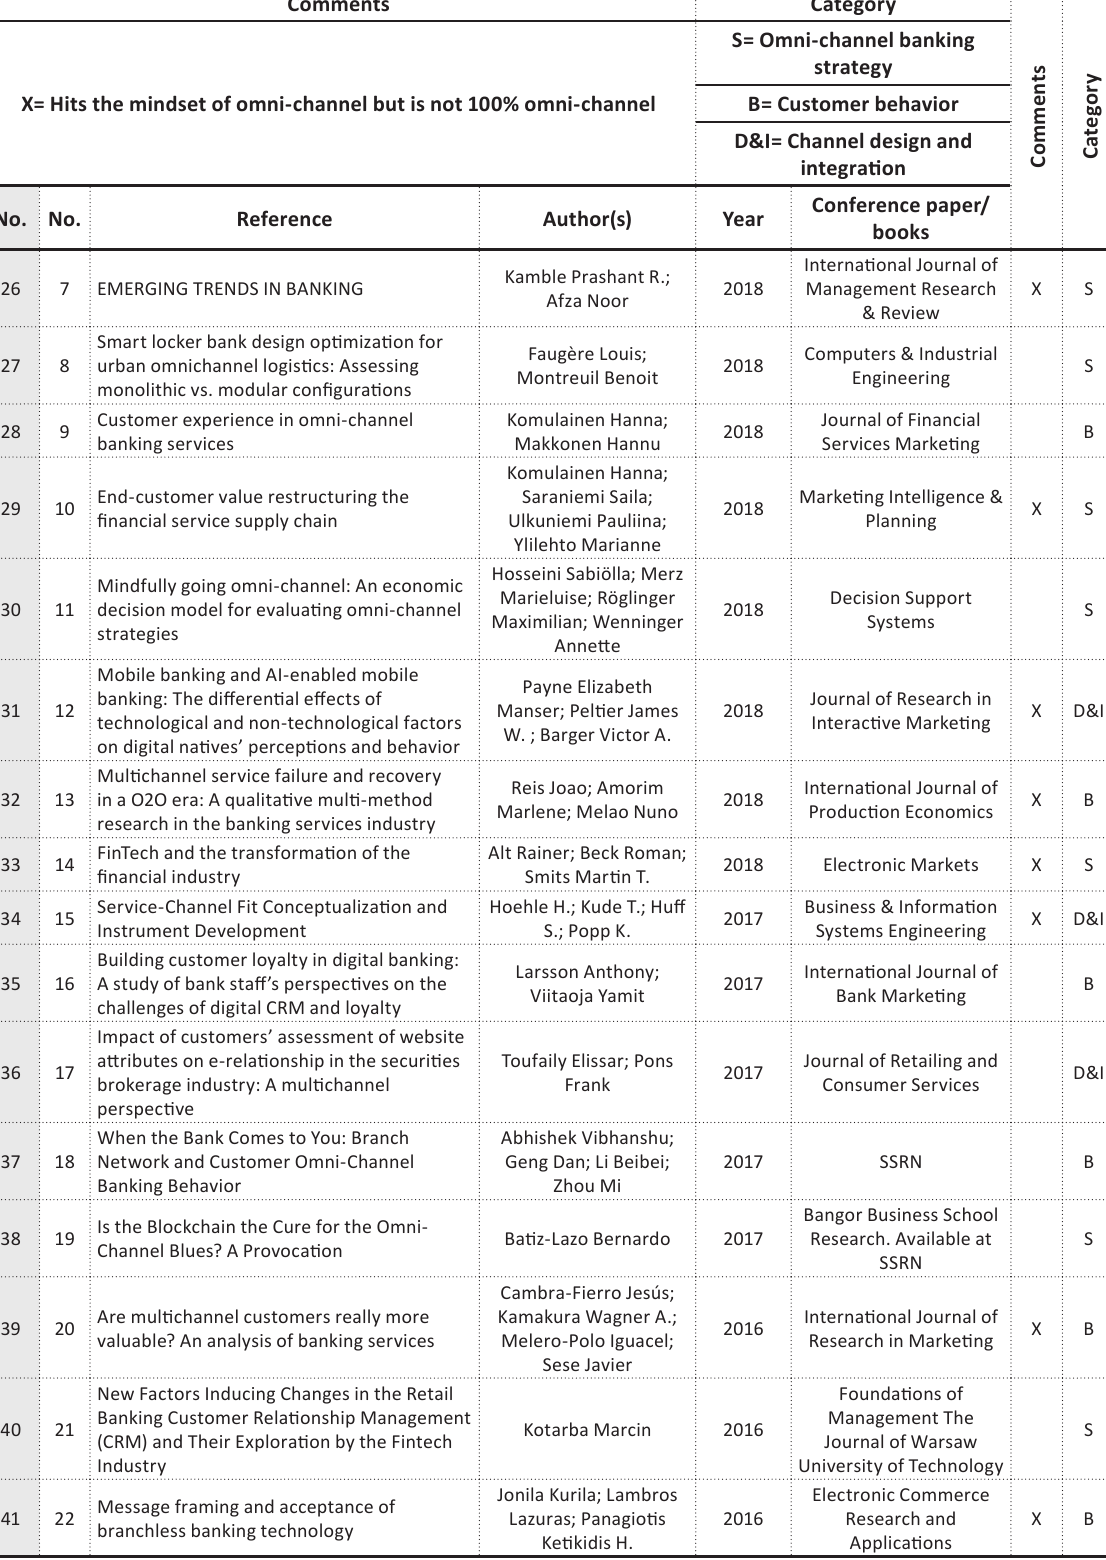
Table A1 (cont.). Omni-channel in the context of banking literature, search phases 3.1,